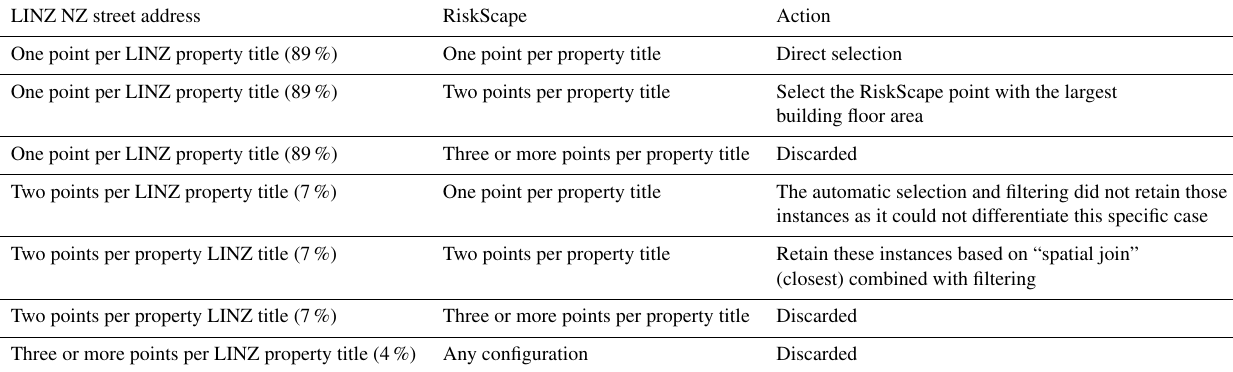
Table 1. Overview of the action taken depending on the number of LINZ NZ street address and RiskScape points present per LINZ NZ property